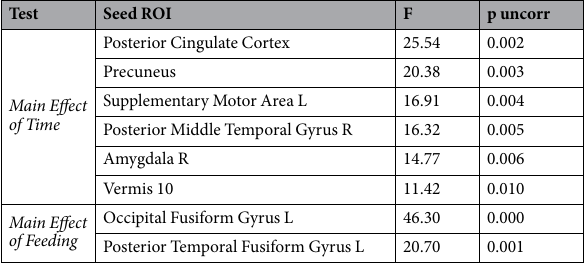
Table 2. Within patients main effect of time and feeding condition on connectivity.